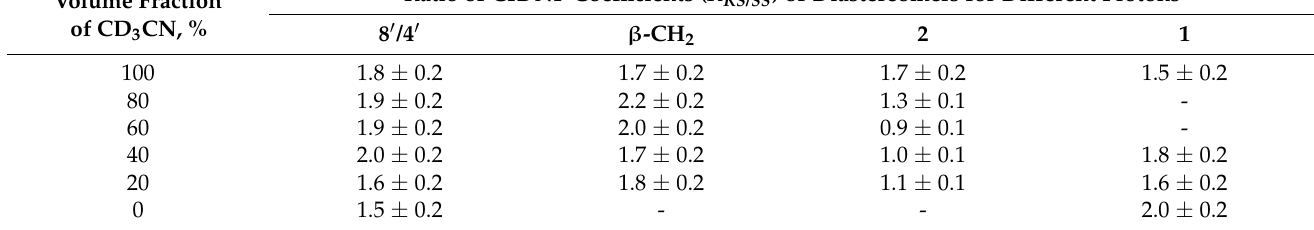
Table 3. Spin selectivity of protons in diastereomers of dyad III detected in solvent with different dielectric constants (mixtures of CD 3 CN/C 6 D 6 ).